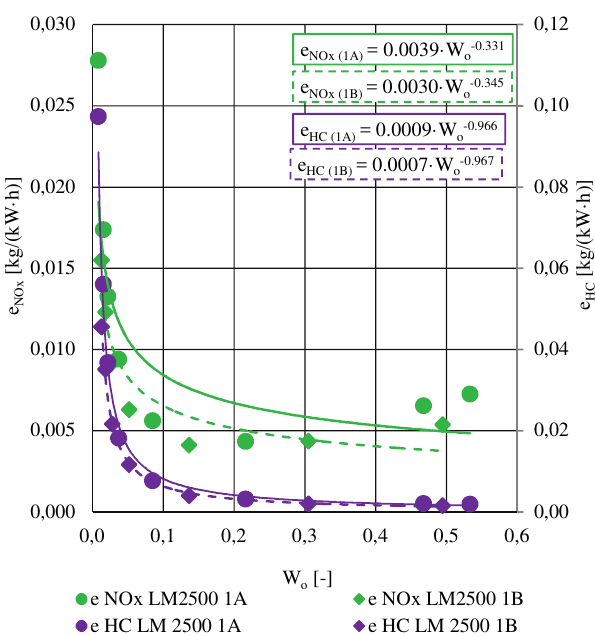
) and hydrocarbons ,"(cid:15)